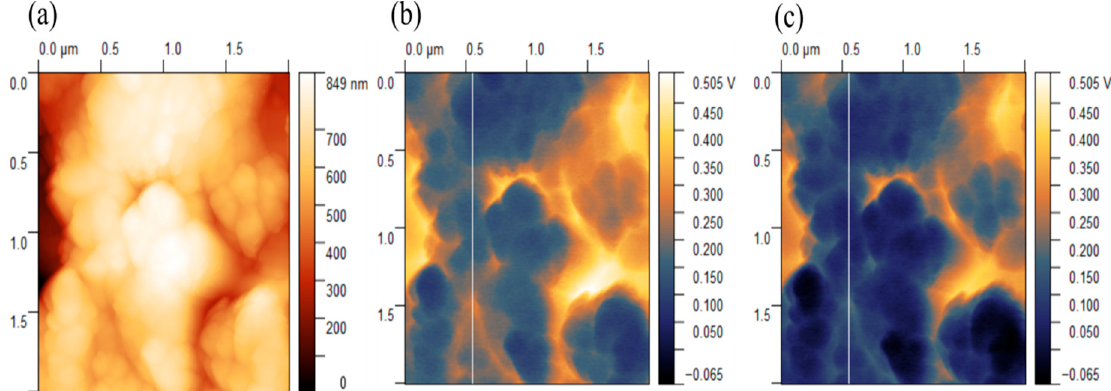
Figure 12. ( a ) Atomic Force Microscopy topography, ( b ) the Kelvin Probe Force Microscopy (KPFM) map of the as-etched silicon nanoflakes under dark conditions, and ( c ) KPFM map of silicon nanoflakes under the illumination condition.